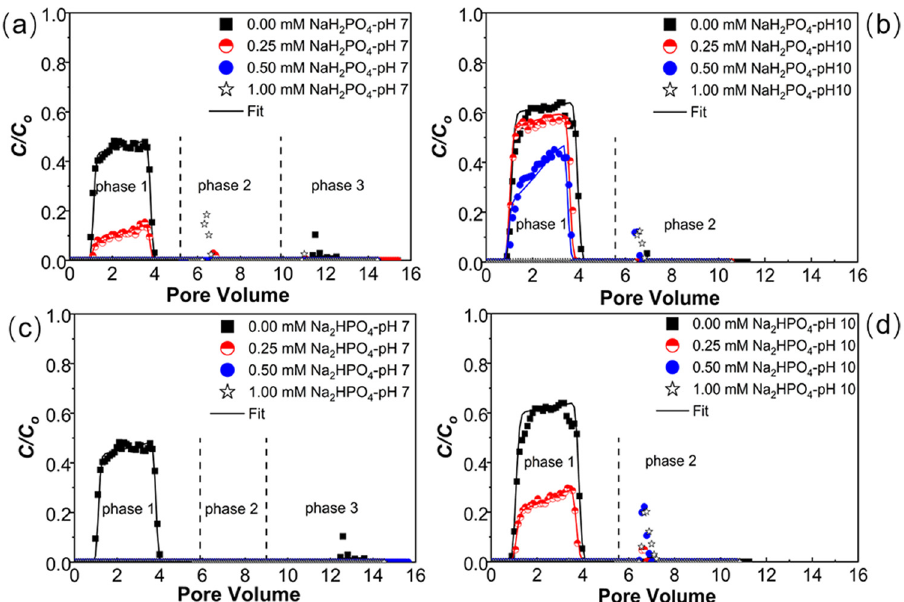
Figure 2. Breakthrough curves of PNPs with NaH 2 PO 4 (0–1 mM) under pH = 7 ( a ) or pH = 10 ( b ); breakthrough curves of PNPs with Na 2 HPO 4 (0–1 mM) at pH = 7 ( c ) or pH = 10 ( d ). All the experiments were carried out in the presence of 1 mM NaCl. The release of PNPs was initiated by eluting with ultrapure water under pH 7 (phase 2) and pH 10 (phase 3), respectively. Only the elution of water at pH 10 (phase 2) was performed when the PNPs were retained under pH 10 in phase